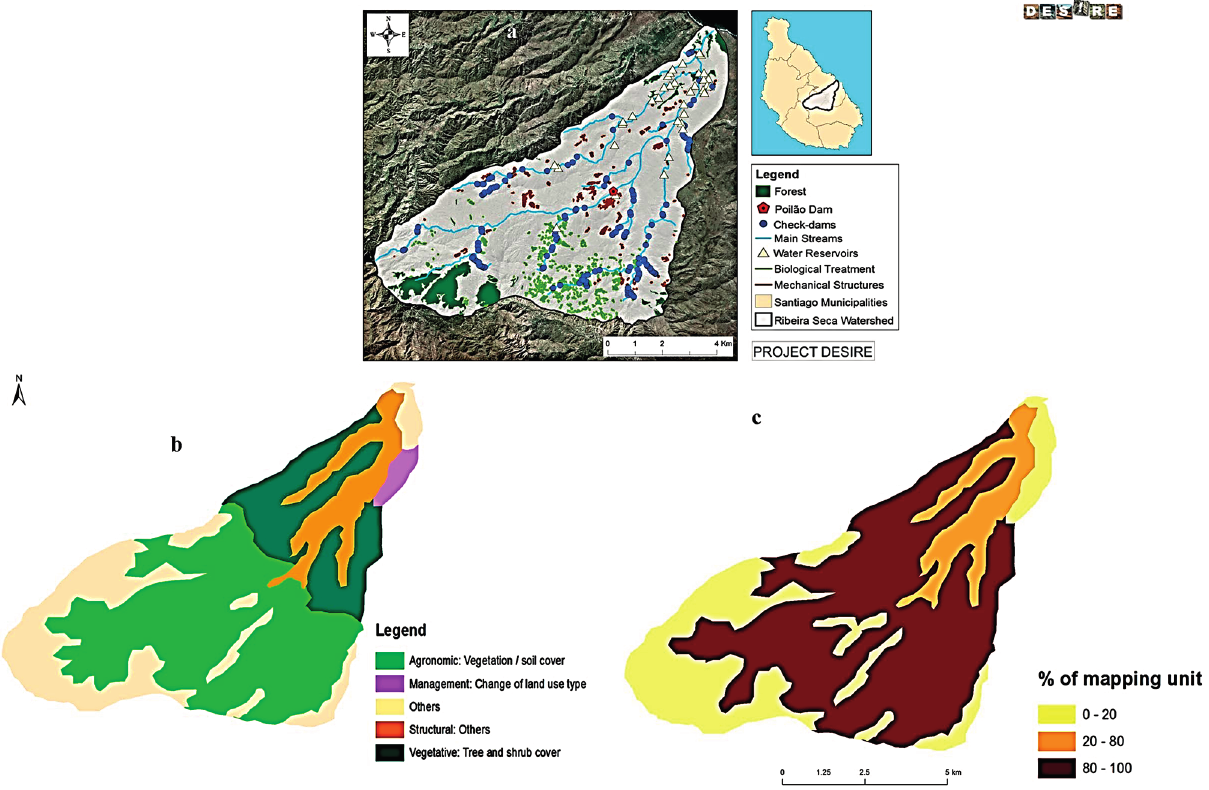
Figure 5. ( a ) Existing soil and water conservation measures ( b ) land conservation group measures and ( c ) extent as % of mapping unit showing the importance of vegetation measures as the major conservation group at hillslope level. (b) and (c) adapted from